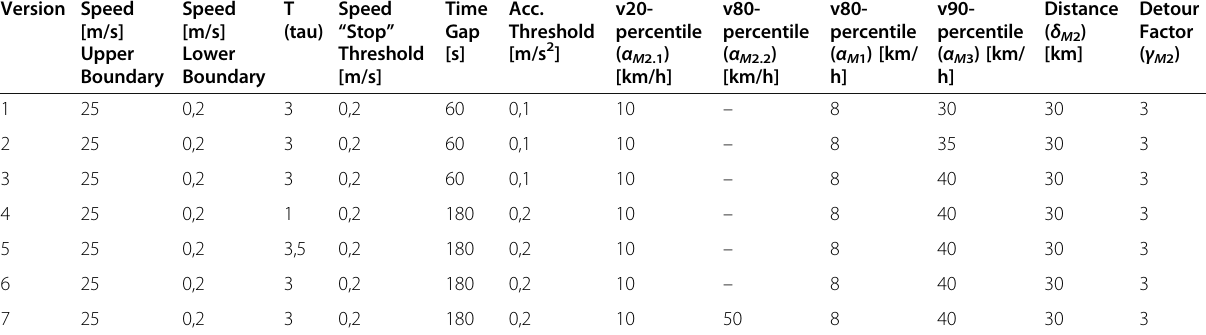
Table 3 Altering of parameter combinations for different steps of data pre processing Version Speed [m/s] Upper Boundary